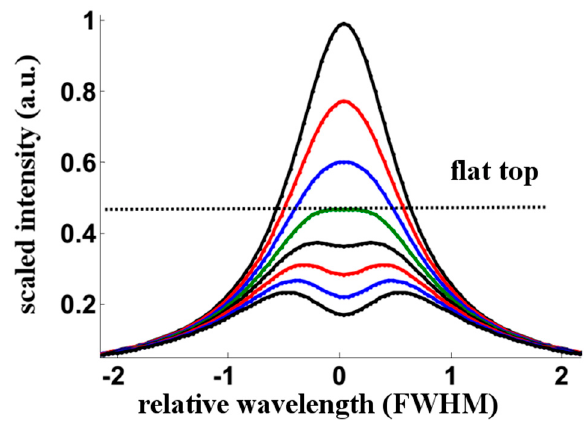
− τ λ ϕ ( λ ) / ϕ 0 vs. wavelength, λ , for fixed ∆ λ 0